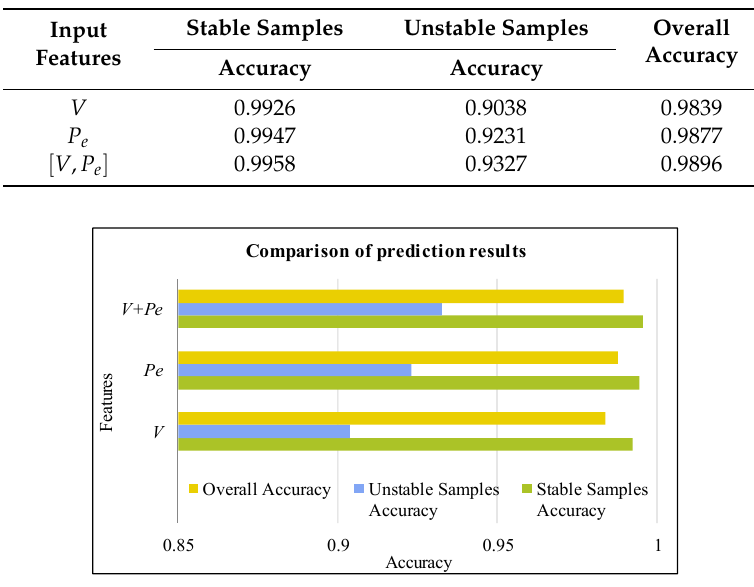
Figure 12. Comparison of prediction results with different features.